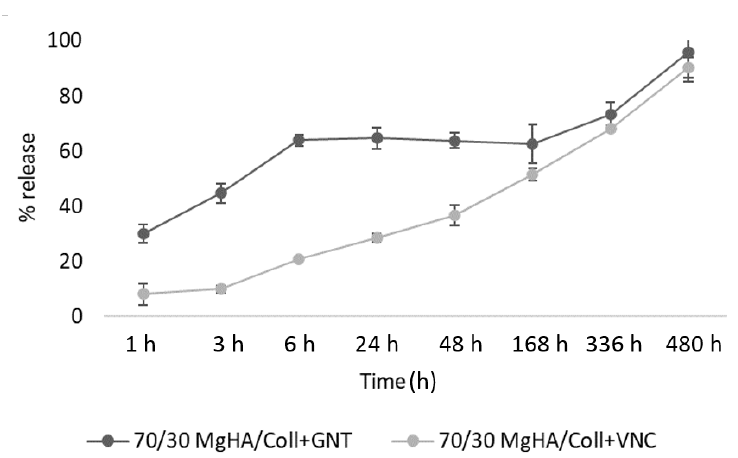
Figure 5. Comparison of the release profiles for GNT and VNC from MgHA/Coll 70/30 wt.% scaf- folds.